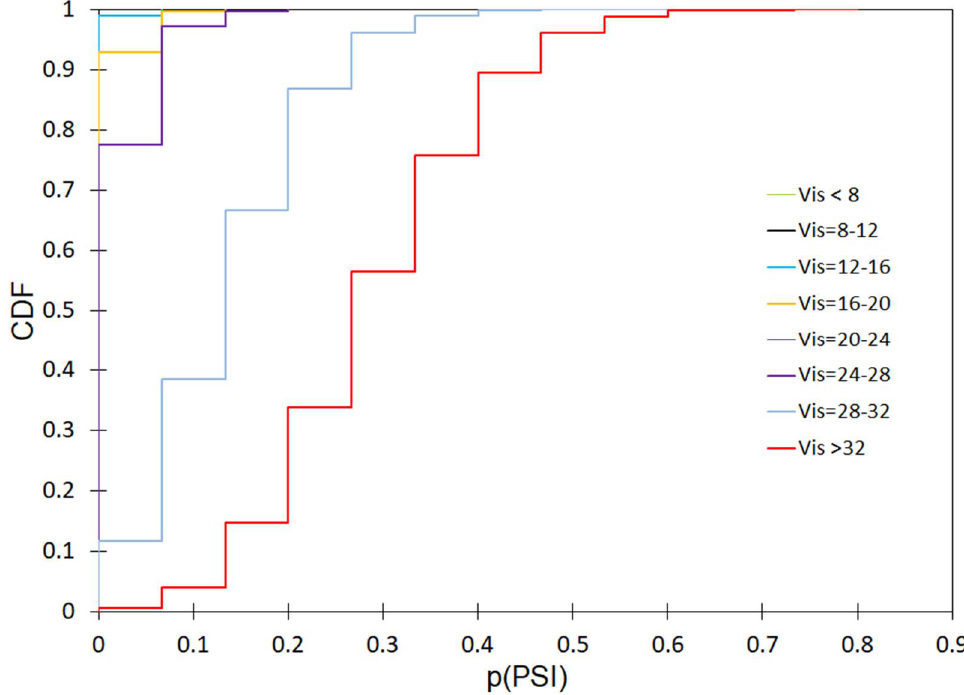
Figure A21. Effect of visibility on the incidence of mean summer mortality for rainy days.